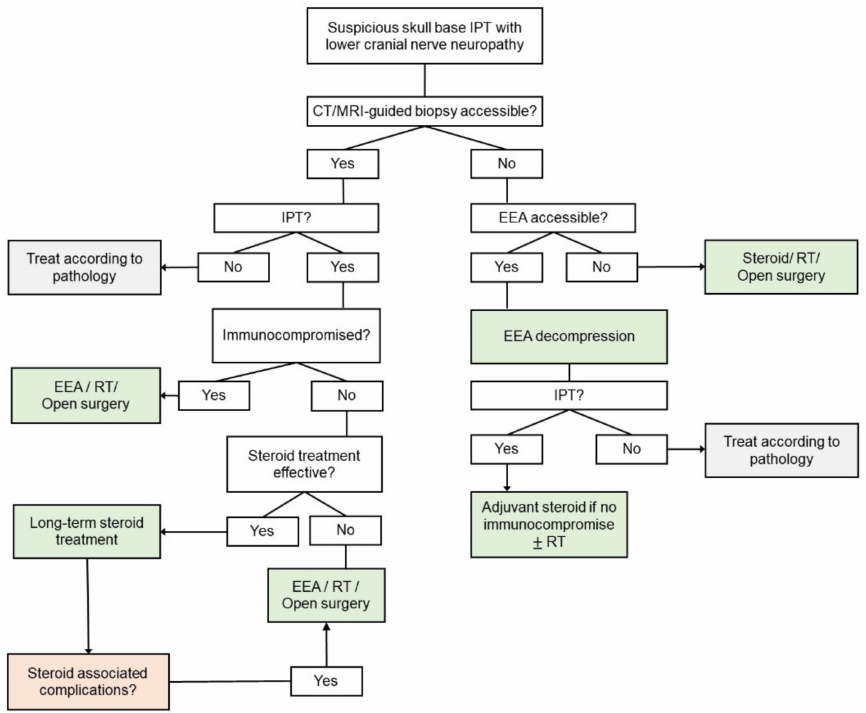
Figure 7. Proposed diagnostic and therapeutic algorithm for suspicious skull base IPT with lower cranial nerve neuropathy. Abbreviations: CT = computed tomography; EEA = endoscopic endonasal approach; IPT = inflammatory pseudotumor; MRI = magnetic resonance imaging; RT = radiation